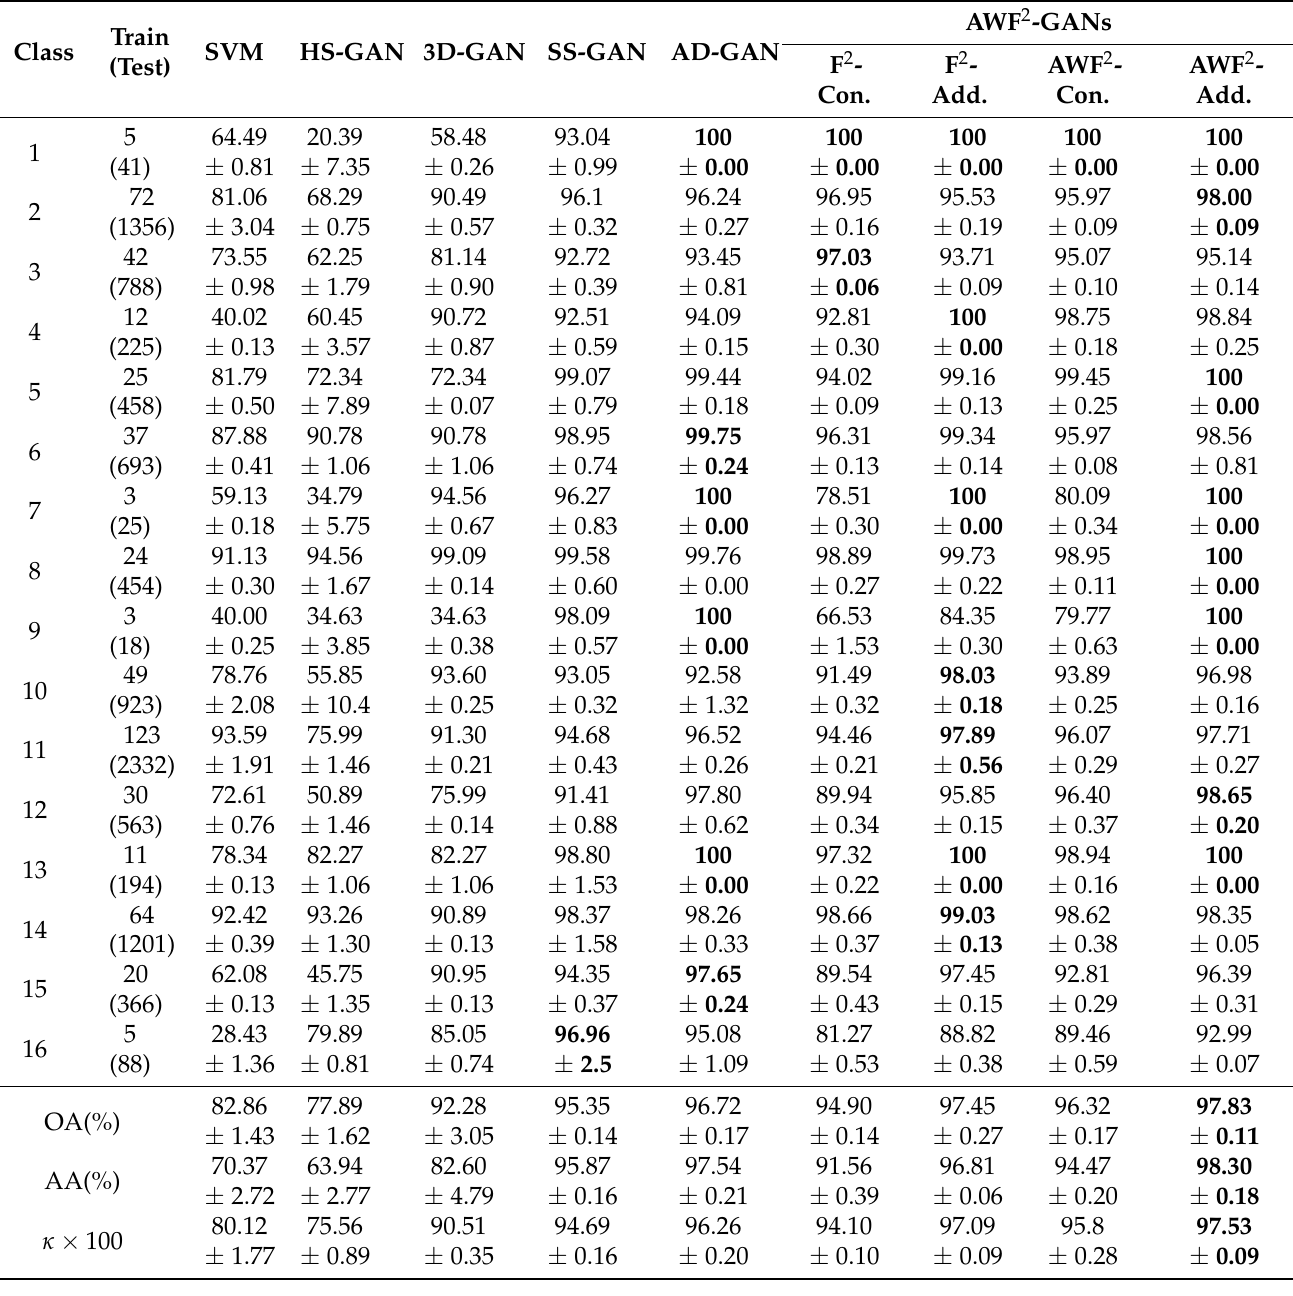
Table 3. The overall accuracy (OA), average accuracy (AA), kappa coefficient ( κ ), and individual class accuracies for the IN dataset with 525 labeled and unlabeled samples for training. The best results are highlighted in bold